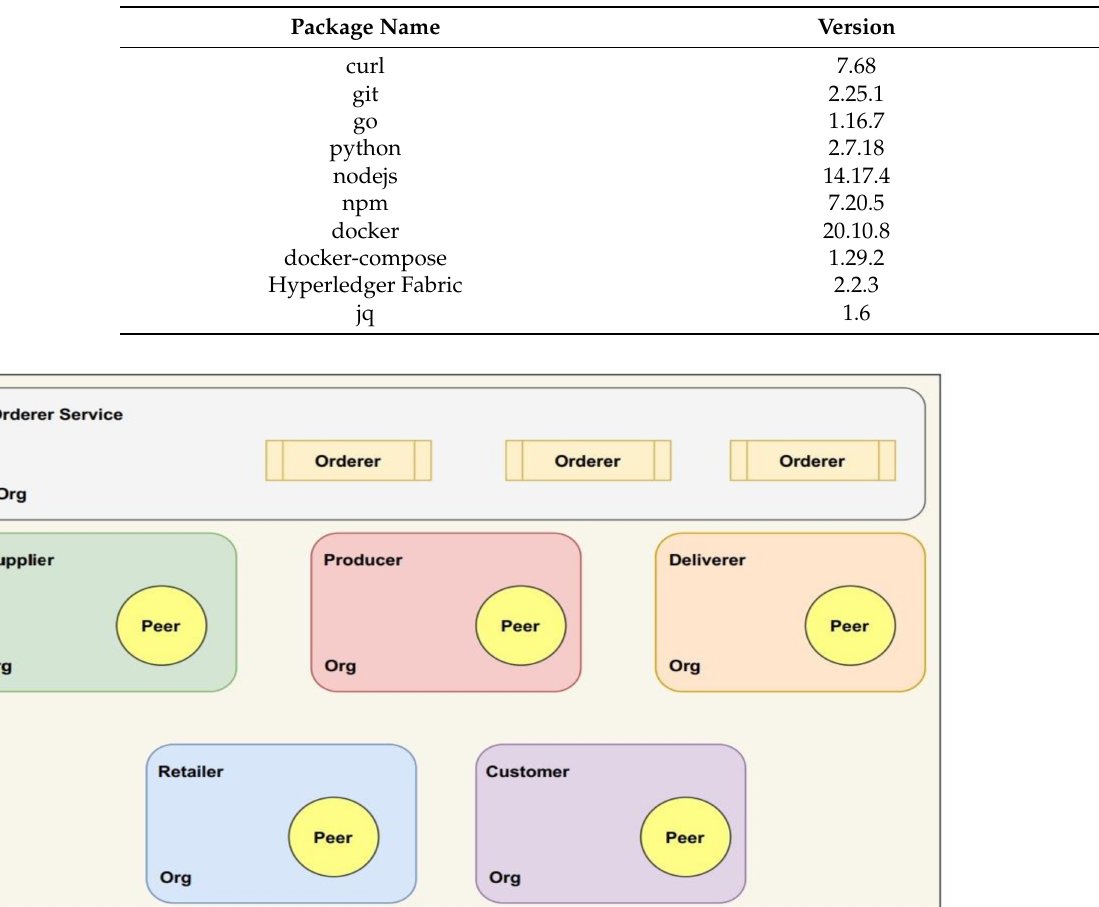
Table 3. Package information used in the installation of the system.